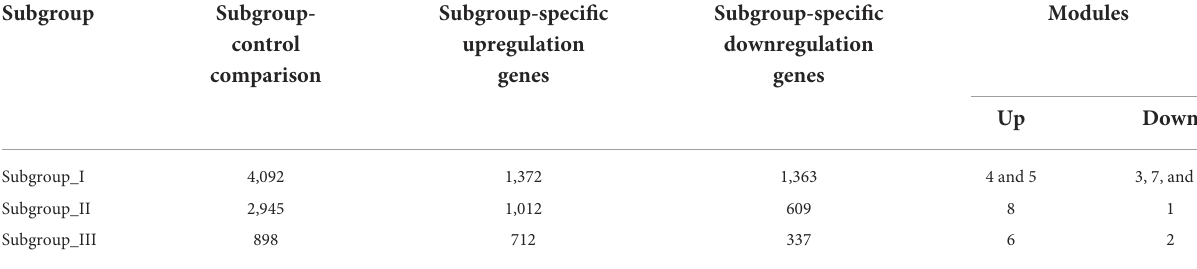
TABLE 1 The number of differentially expressed genes by case-control and case-case comparisons and co-expression modules in each